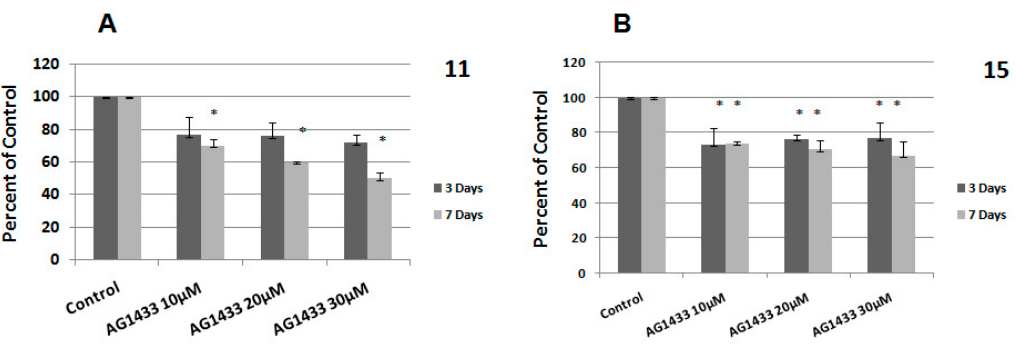
Figure 2. Effect of inhibition of PDGFR on glioblastoma ( GBM) cells viability: 11 HGG cells ( A ) and 15 HGG cells ( B ) were seeded in 96-well culture plates (1–10 × 10 3 cells/well) and treated with AG1433 for 3 days (grey bars) and for 7 days (black bars). Results are expressed as percentage of control and each experiment was repeated at least three times. Data are mean and standard error of three separate experiments. Data are reported as the mean ± SD (error bars). * p < 0.05 vs. untreated control cells.